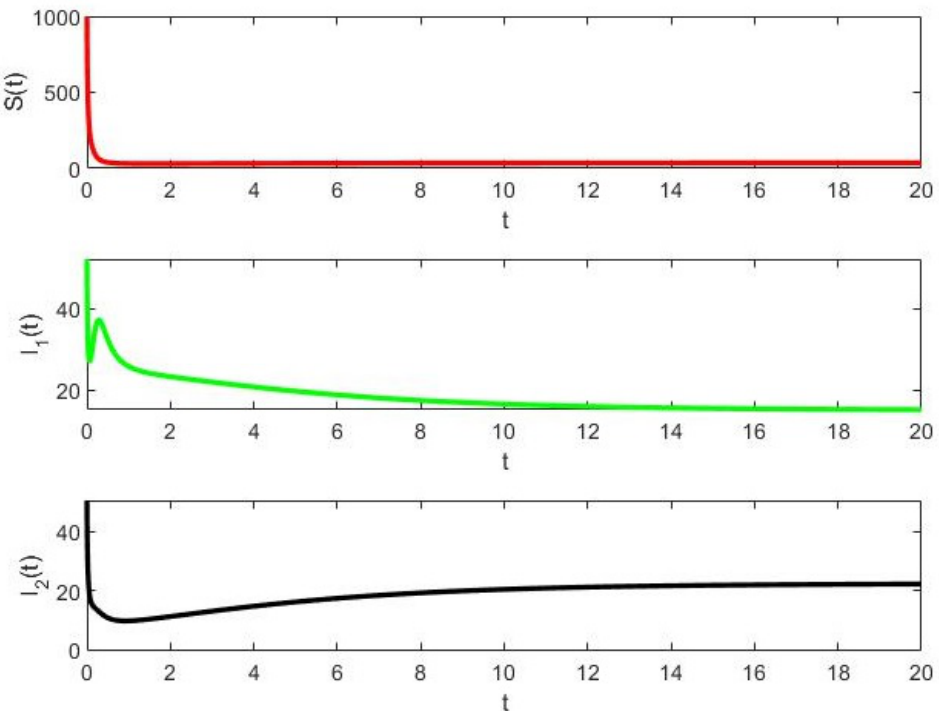
Figure 4. Example 3: deterministic solution for S ( 0 ) = 1000, I 1 ( 0 ) = 52, I 2 ( 0 ) = 51.